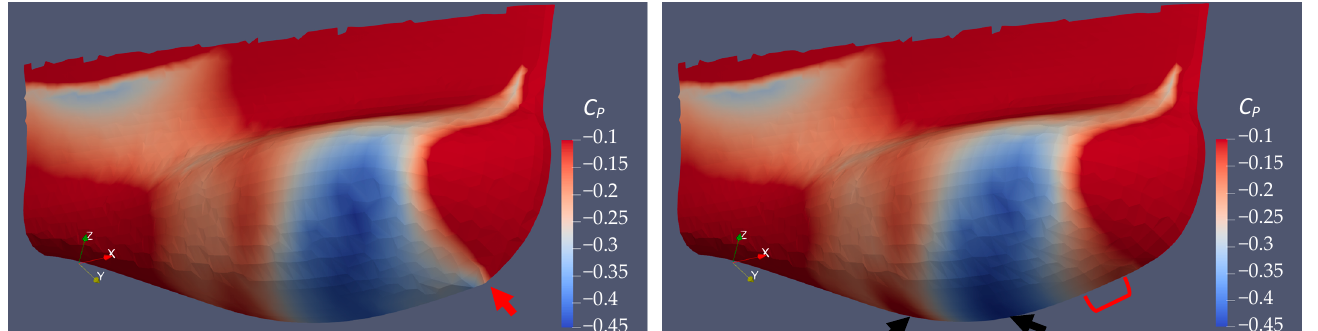
Figure 14. Low pressure distribution ( − C P ) on sonar dome surface (left: B17.018; right: B17.018v). The red arrow points to the sharp tip of the front edge of B17.018 sonar dome. The red bracket shows the front edge fairing for B17.018v. The black arrows indicate lower C P on the dome bottom and higher C P on dome slope for B17.018v compared with B17.018.